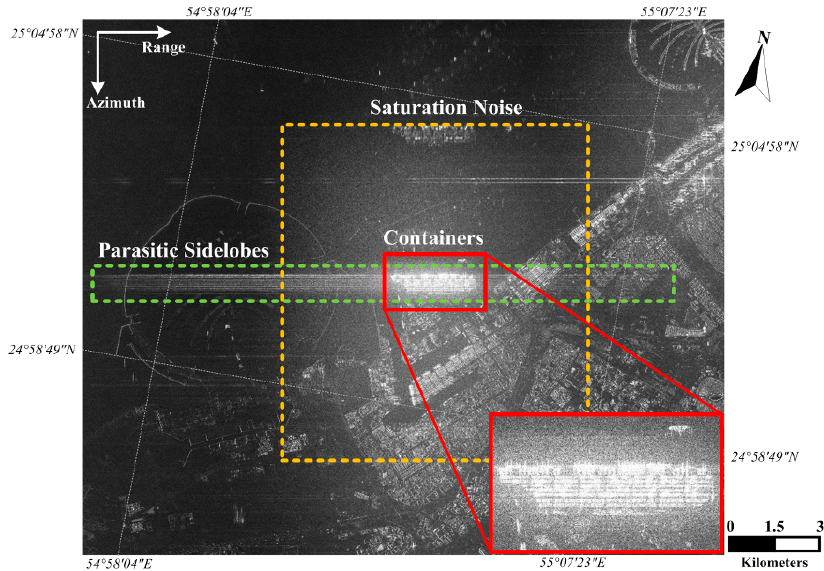
Figure 7. The saturation of extremely strong targets in a Radarsat-2 image of Dubai. There is a container terminal at the center of the image. The placement direction of the containers (in the red rectangle) is perpendicular to the azimuth direction. Thus, the scattering intensity in this area is significantly higher than that in the remainder of the image.